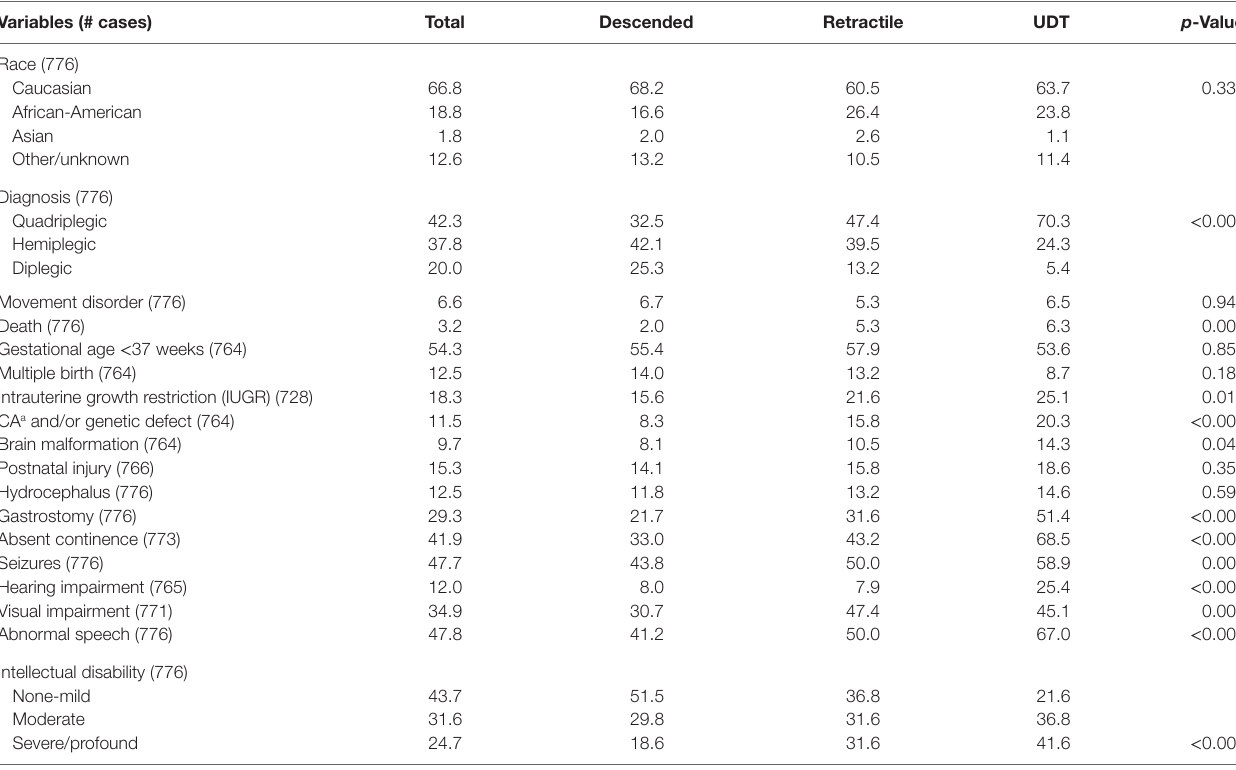
TaBle 1 | Frequencies (%) of clinical characteristics by cryptorchidism subtype in boys with cerebral palsy. Variables (# cases) Total Descended retractile